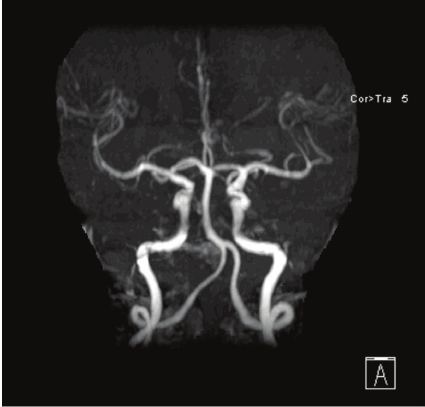
Figure 9: TOF-MRA scan after one year demonstrating persistent obliteration of coiled ICA